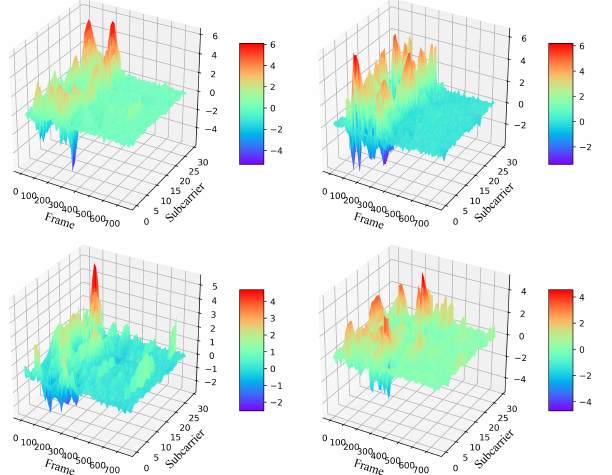
Figure 4. The sparse component of CSI for the identical activity at four different